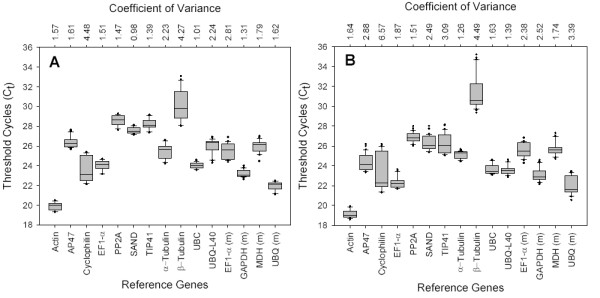
Absolute Ct from 2003 pericarp (A) and 2004 pericarp (B) samples. Each box indicates 25/75 percentiles. Whisker caps represent 10/90 percentiles. The median is depicted by the line and all outliers are indicated by dots.